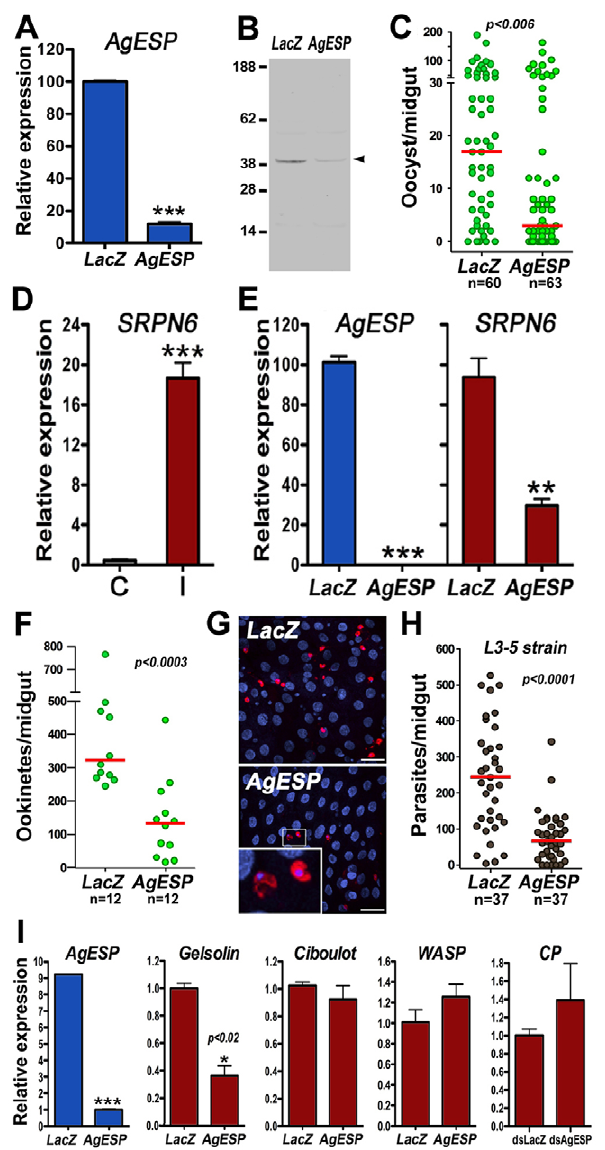
Figure 3. Effect of AgESP silencing on Plasmodium berghei infection. AgESP mRNA (A) and protein (B) silencing in the mosquito midgut by systemic dsRNA injection. (C) Effect of AgESP silencing on the number of P. berghei oocysts present in the midgut 7 days post infection. (D) Effect of P. berghei infection on SRPN6 expression. SRPN6 mRNA levels in midguts of mosquitoes fed on a healthy mouse (C, control; grey bar) or a P. berghei- infected mouse (I, infected; red bar). (E) Effect of AgESP silencing on expression of AgESP (blue bars) or SRPN6 (red bars) 24 h after ingestion of a Plasmodium -infected blood meal. (F) A significant reduction in number of parasites that invaded mosquito midgut was already observed in AgESP-silenced mosquitoes 28 h post feeding (PF). (G) Immunostaining of the ookinete surface with anti-Pb28 antibodies (red) and nuclear staining with DAPI (blue). There are fewer ookinetes in AgESP-silenced midguts, but no evidence of parasite fragmentation was observed. (H) Effect of AgESP silencing in the refractory Anopheles gambiae L35 strain on the number of melanized parasites (black dots). Each dot represents the number of parasites on an individual midgut. Live parasites are shown in green and melanized parasites in black. The red line indicates the median. Distributions were compared using the Mann-Whitney test. (I) Effect of silencing AgESP (blue bars) on the expression of gelsolin, Ciboulot, Wiskott-Aldrich syndrome protein (WASP), and F-actin capping protein